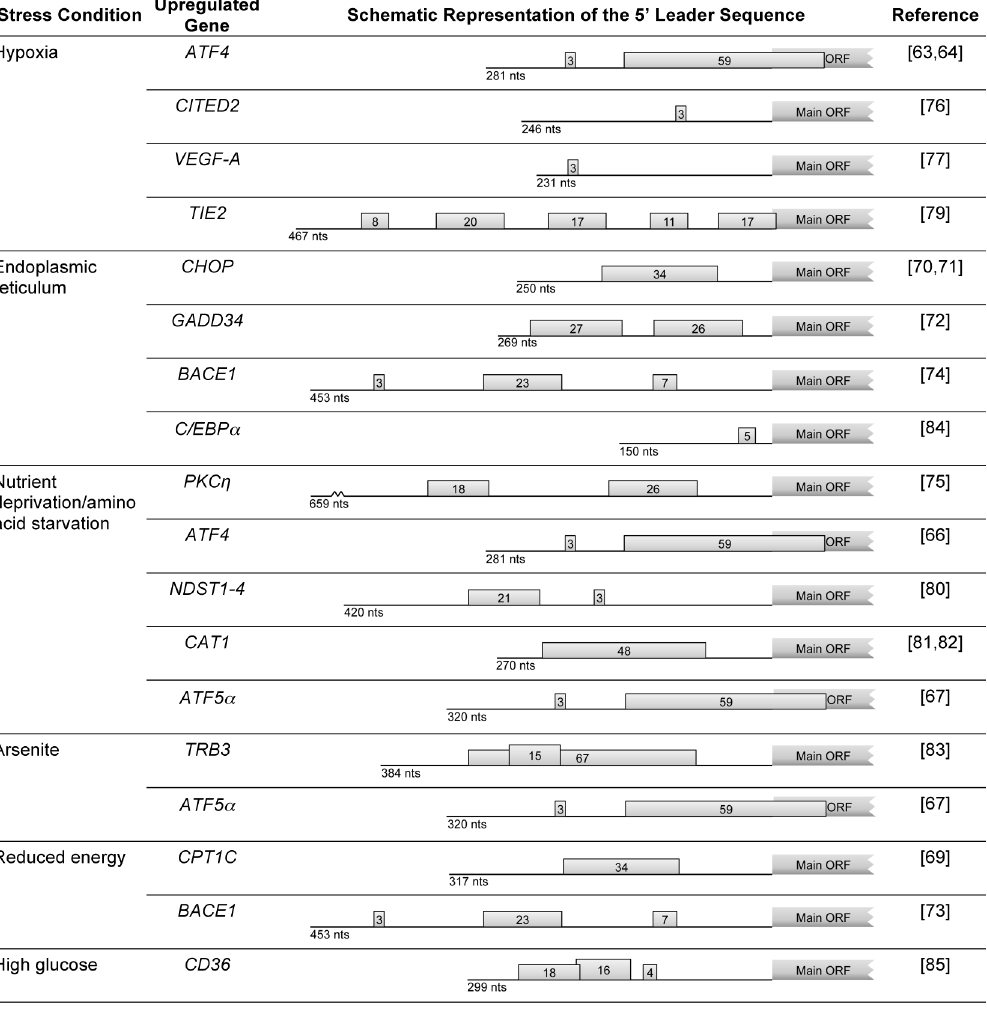
Figure 2. Examples of human genes encoding mRNAs that, under stress conditions, evade global repression of translation and are upregulated due to the presence of uORFs. For each mRNA, the schematic representation of the 5 9 leader sequence is shown with the length (in nucleotides; nts) indicated below each representation; boxes with numbers represent the uORF(s), where the number indicates the corresponding length in codons.